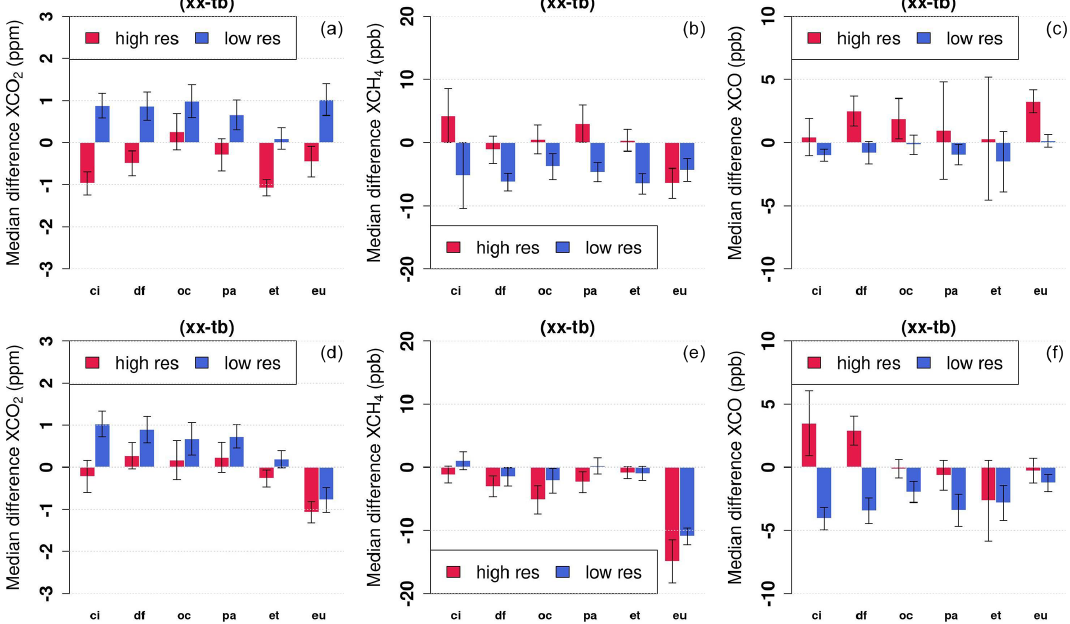
Figure 9. These figures show the differences between the 10min averaged EM27/SUN and TCCON XCO 2 (in ppm) and XCH 4 and XCO (both in ppb) from coincident measurements collected throughout the 2018 field campaign and 2020 Arctic campaign. The colour bars show the median biases relative to the reference EM27/SUN (tb) at each TCCON station. The error bars on each colour bar represent the median absolute deviation in the 10min averaged biases. Panels (a) – (c) show GGG2014 and panels (d) – (f) GGG2020 results,